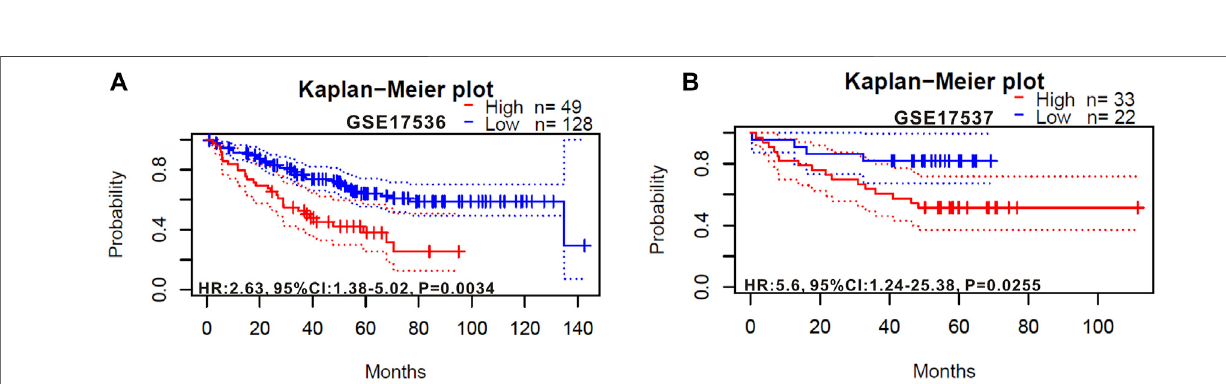
Frontiers in Genetics |